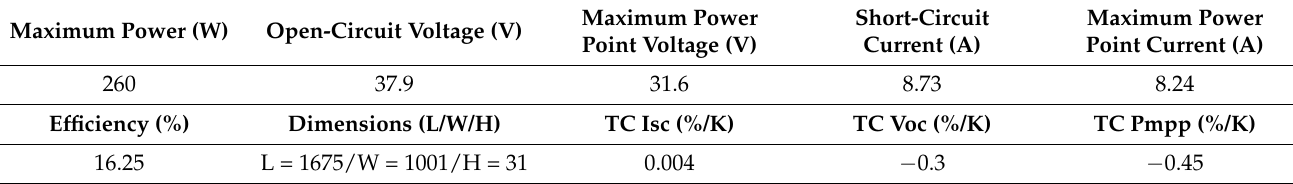
Table 1. Properties of 260 W mono-silicon panel under standard test